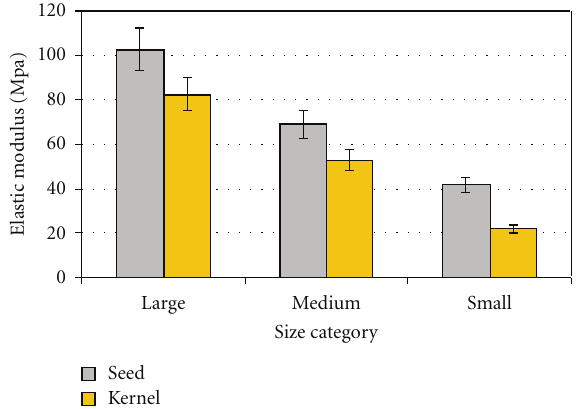
Figure 4: E ff ect of size on elastic modulus of pumpkin seed and its kernel.